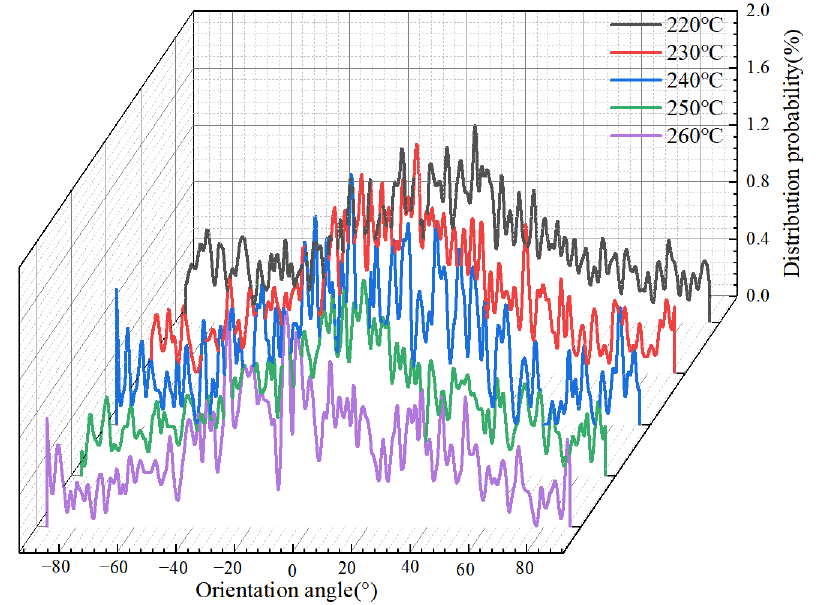
Figure 24. Orientation angle distributions of PP at different melt temperatures along the flow direc-